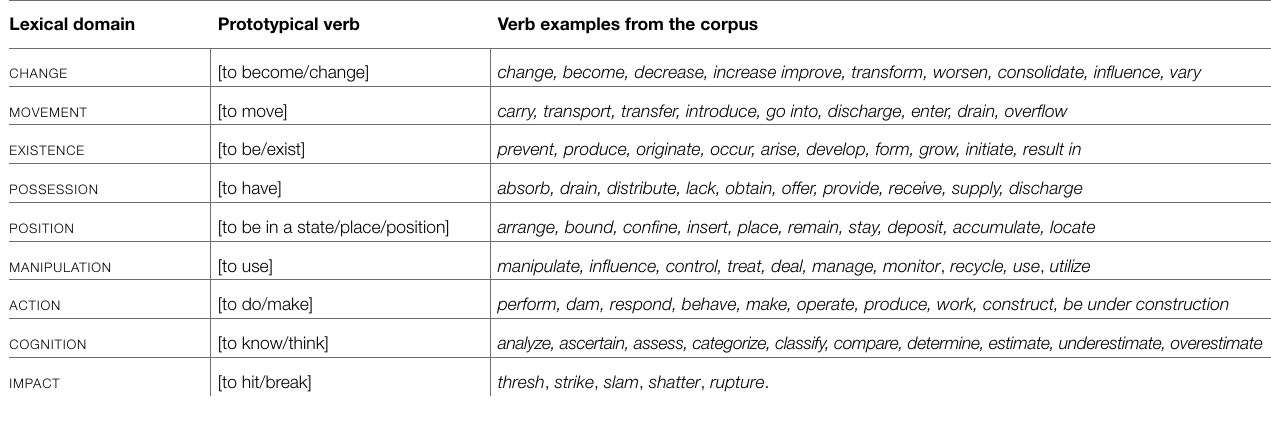
TABLE 1 | The most frequent lexical domains of environmental verbs (Faber and Cabezas-García, 2019, p. 206). Lexical domain